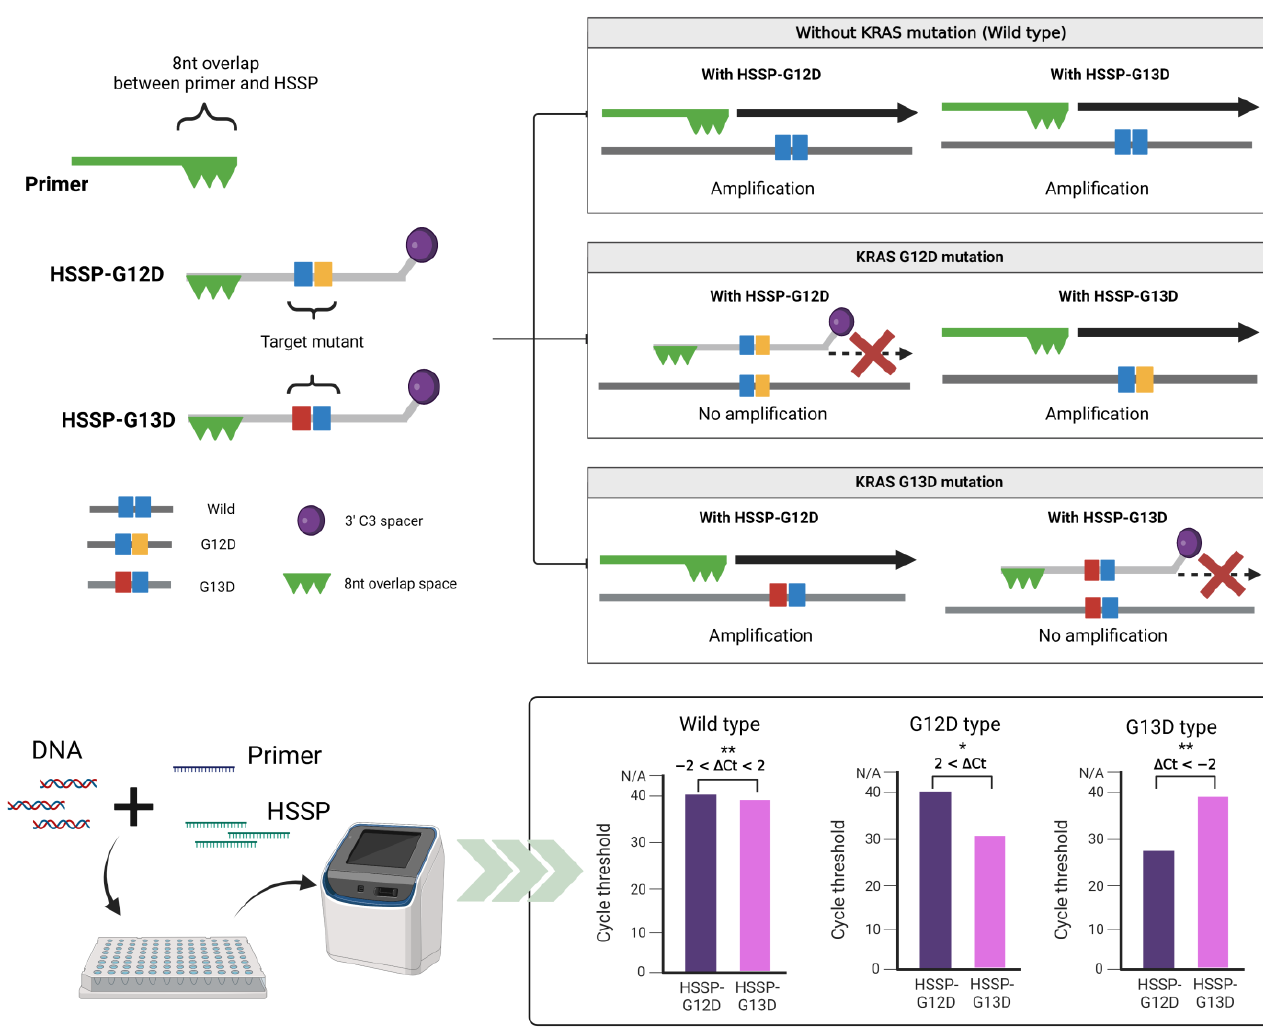
Figure 1. Schematic representation of the principle of HSSP. The hot spot-specific probe (HSSP) is designed to overlap with PCR primers and contains a specific sequence of single mutations. DNA of the target mutation sequence competitively attaches to the HSSP before the primer binds, which prevents amplification. In the case of sequences different from HSSP, the primer is attached and amplified. In the case of HSSP with qPCR, mutants can be checked by detecting a mutation from the difference in the C t values within 1.5 h. Calculation of the difference between the C t values when using HSSP-G12D and HSSP-G13D. If it is higher than 2, it has the G12D mutant; if it is lower than − 2, it has the G13D mutant. A value between 2 and − 2 is considered wild-type; * p < 0.05, ** p < 0.01.